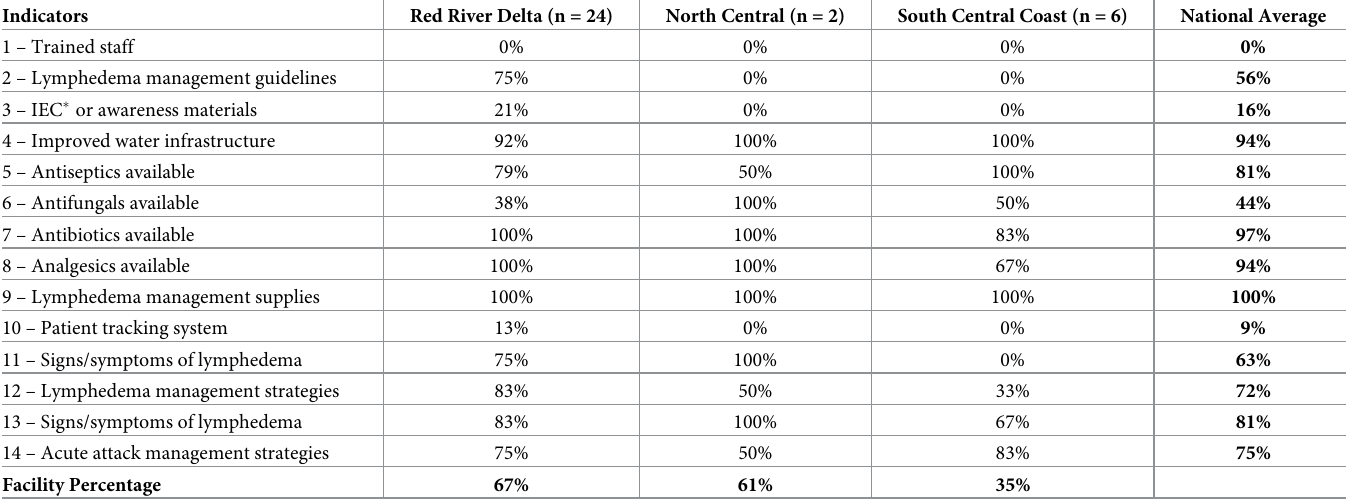
Table 3. Average indicator scores by region and national, direct inspection protocol, Vietnam, 2016. Indicators